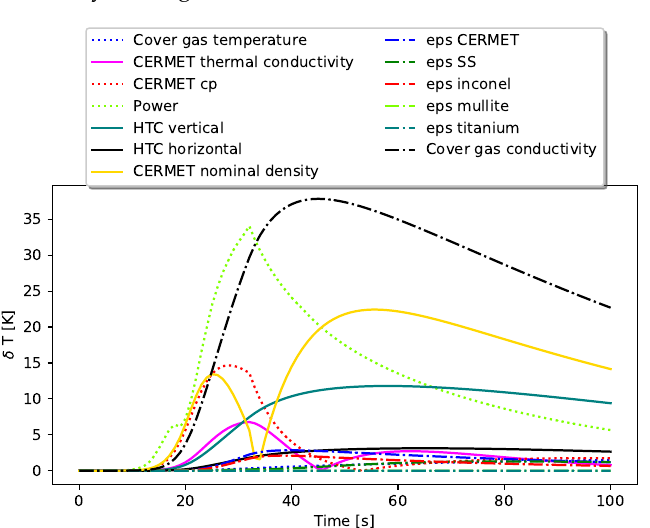
Figure 14. Contribution of the different uncertainties in input parameters to the uncertainty of the temperature